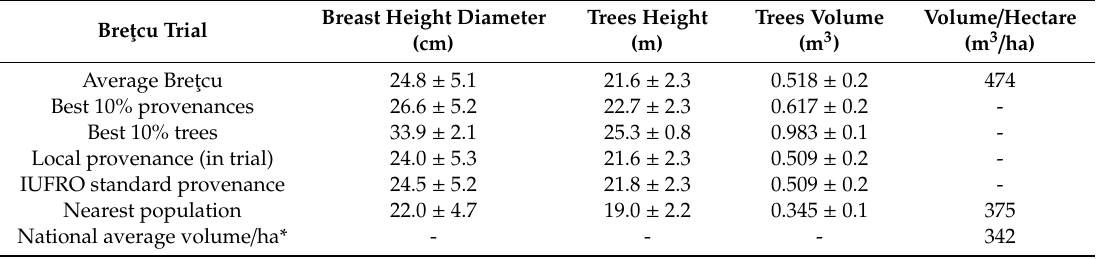
National average volume / ha* -